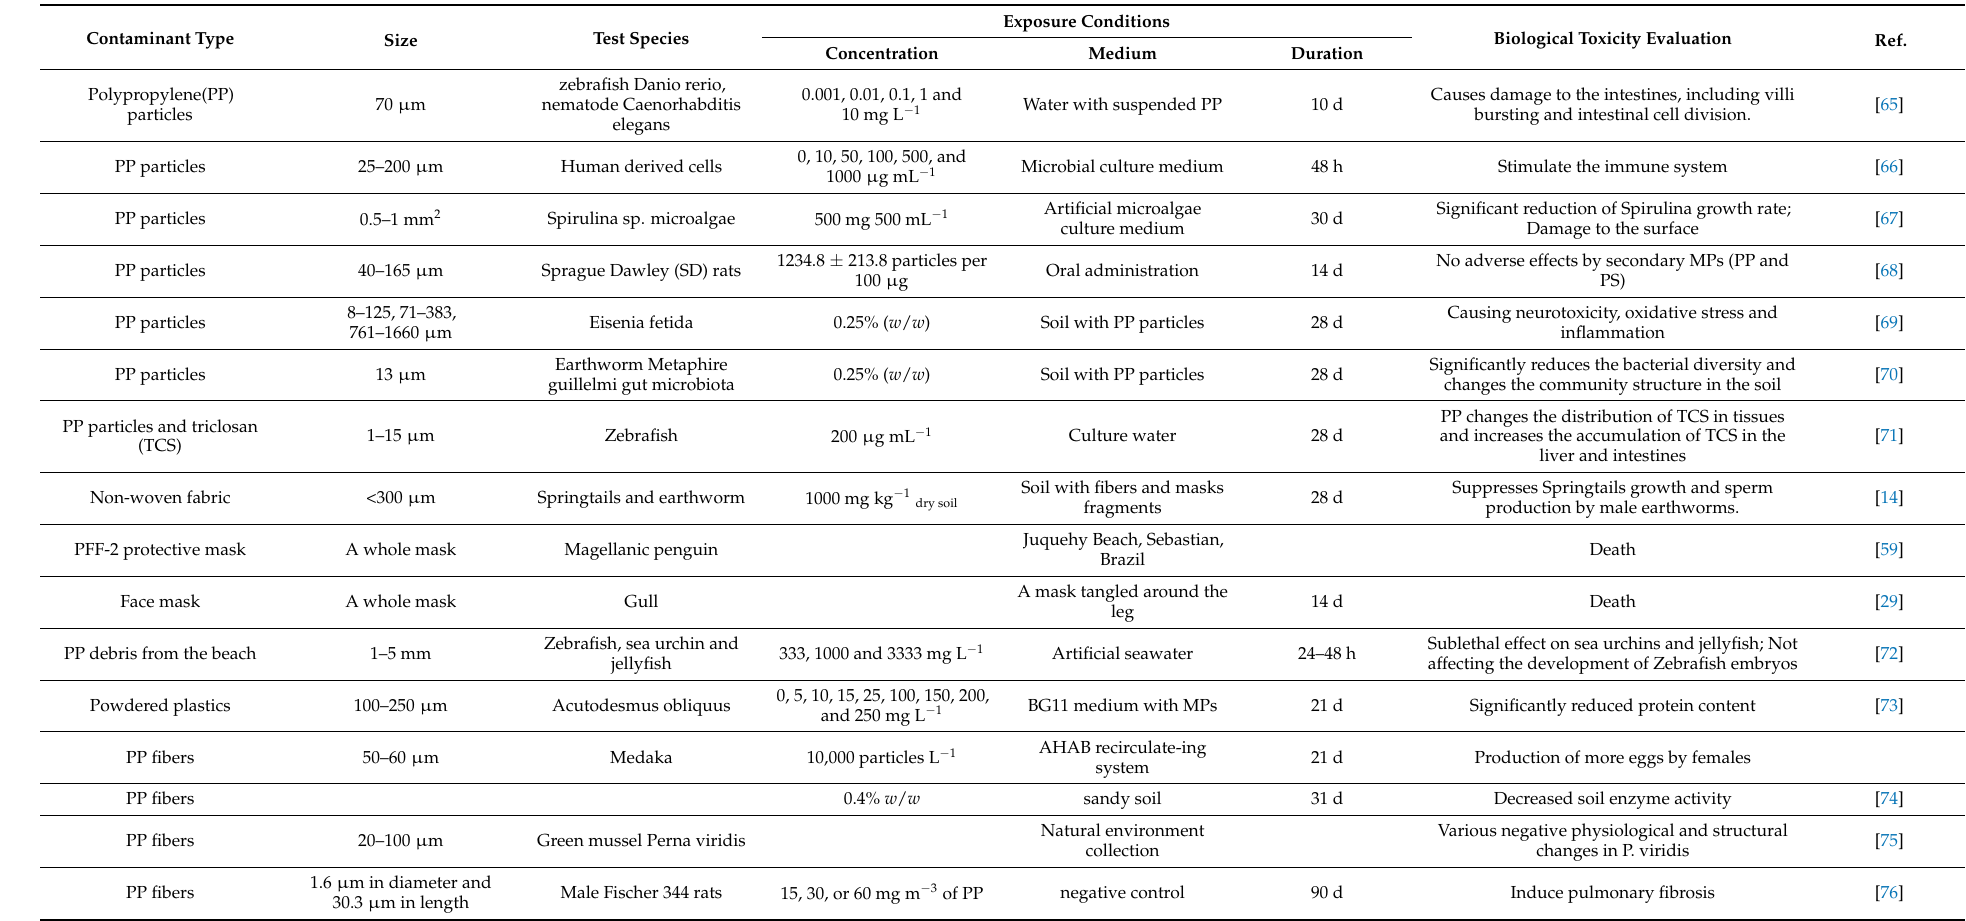
Table 2. Toxicity of mask fragments or